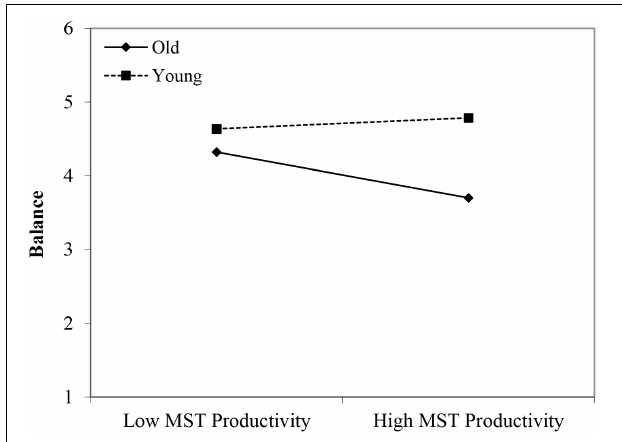
FIGURE 13 | Interaction between perceived age-based (meta-)stereotyping reliability and age groups: Predicting balance. Low = –1 SD , High = + 1 SD , MST = perceived age-based (meta-)stereotyping, old = older workers, middle = middle-aged